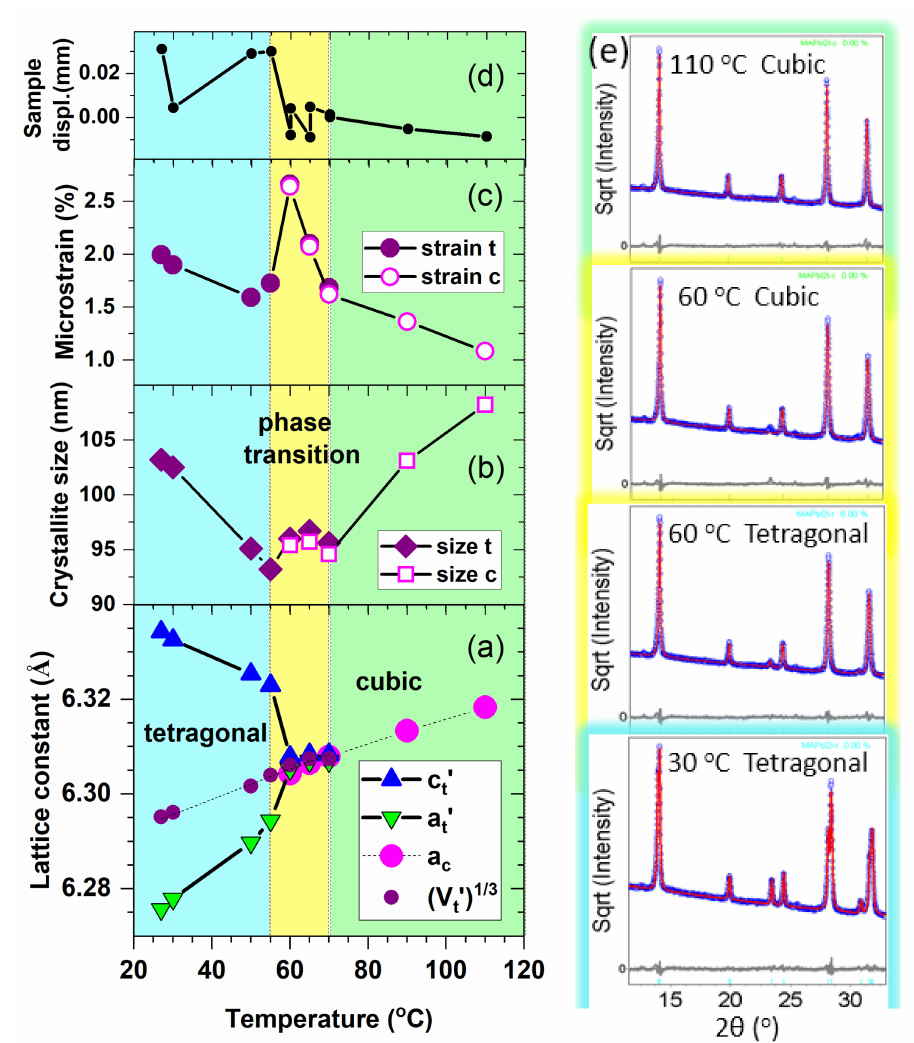
Figure 2. Evolution of the structure parameters determined by XRD: ( a ) lattice constants; ( b ) crystallite size; ( c ) microstrain; ( d ) sample displacement; ( e ) fitted diffractograms: experimental data (blue points), simulated profile (red line) and difference curve (grey line). Between 60 and 70 ◦ C, the diffractograms were fitted either with a cubic or a tetragonal